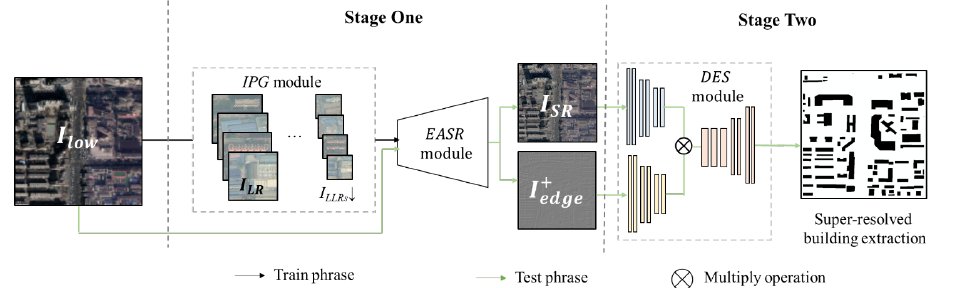
Figure 1. The overall workflow of proposed two-stage building extraction using the LR images approach. Stage one, which consists of internal pairs generation module (IPG) and edge-aware super-resolution module (EASR), focuses on image super resolution. Stage two focuses on building extraction, which contains dual-encoder building segmentation module